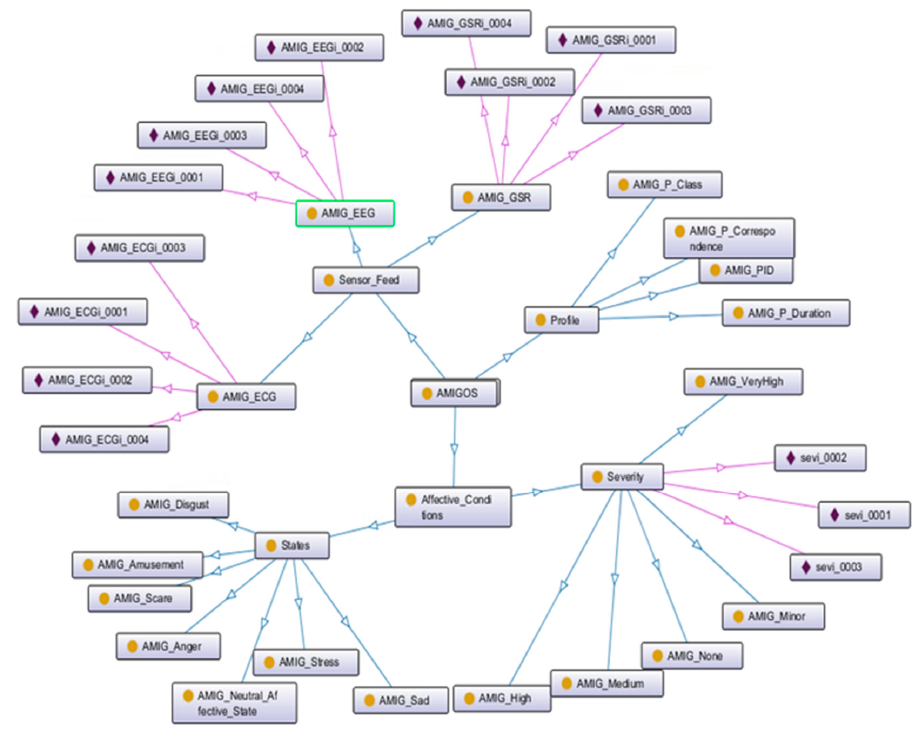
Figure 14. AMIGOS semantic Ontology Model. Appl. Sci. 2019 , 9 , x FOR PEER REVIEW